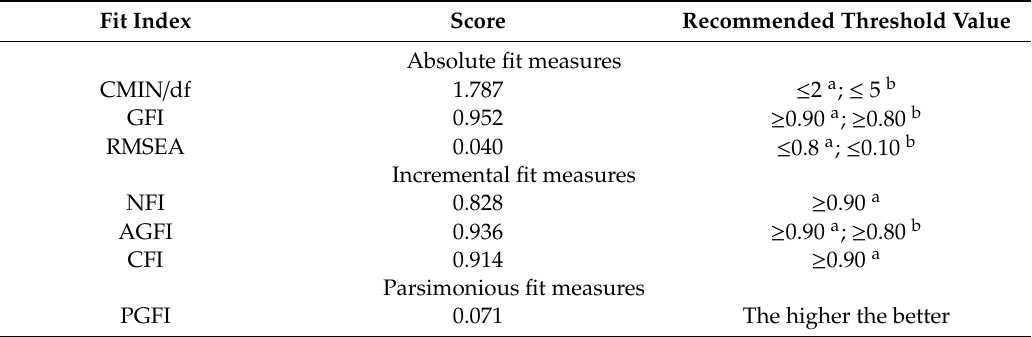
Table 3. Overall fit index of the CFA model.